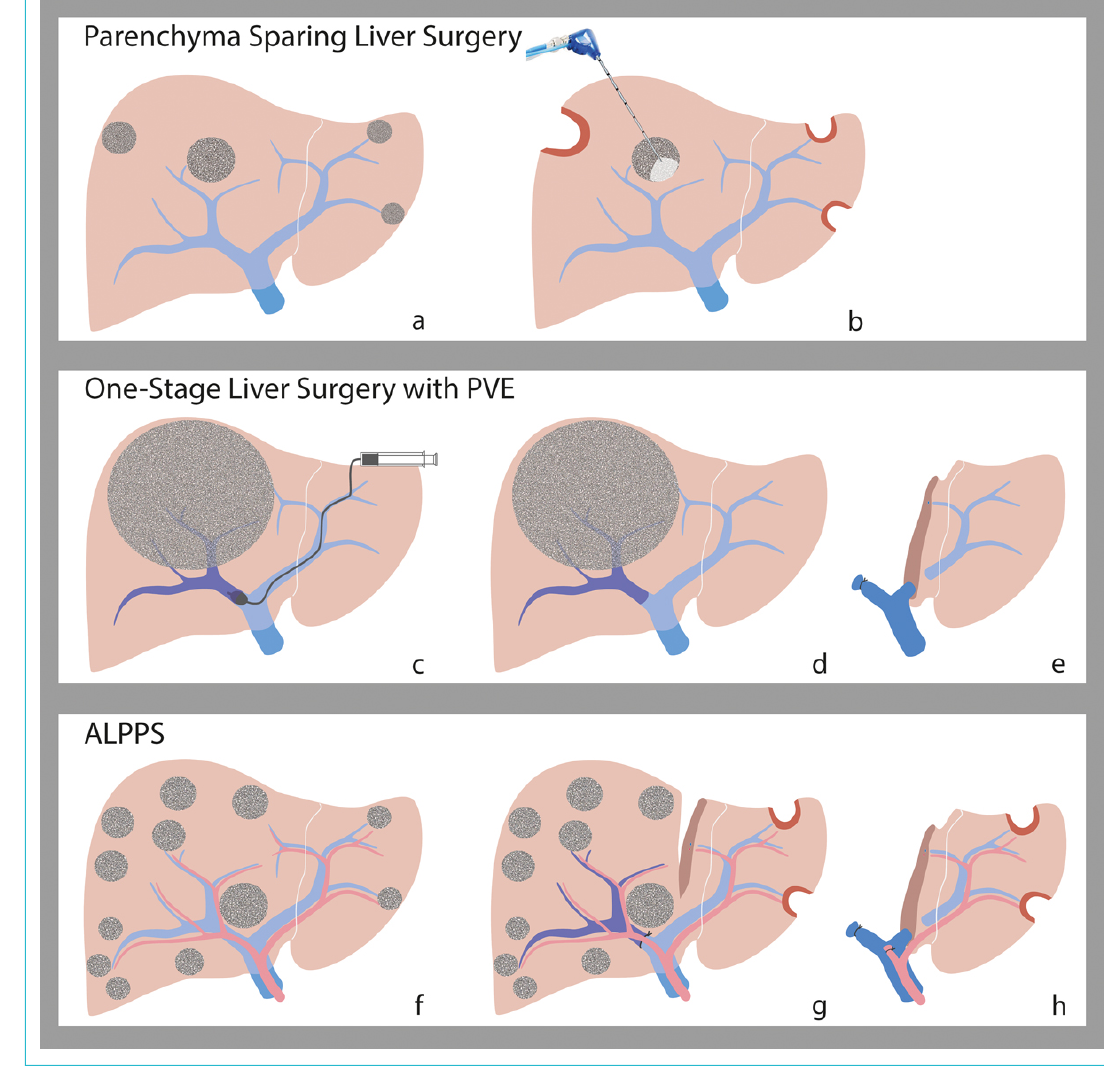
Figure 3: Strategies to increase the future liver remnant. (a) Parenchyma with bilobar CRLM before wedge resections (b) After wedge resec- tions of small peripheral CRLM (c) One-stage liver surgery with portal vein embolisation on the lobe to be removed. (d) Hypertrophy of the FLR. (e) Removal of the embolised right lobe. (f) Bilobar CRLM before surgery g) Open ligation on the right portal vein branch and cleaning of the FLR. (h) Removal of the deportalised lobe. Illustration: Carol De